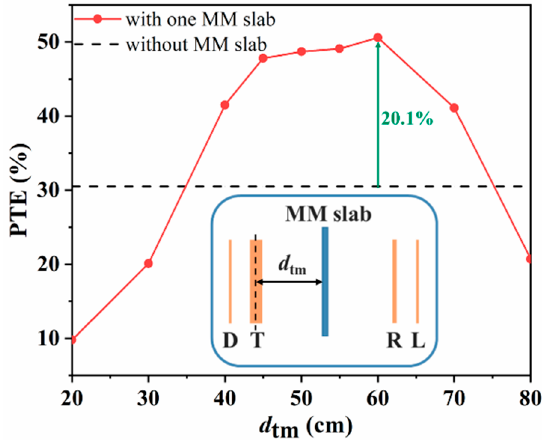
Figure 8. Relationship between PTE and d tm with one MM slab.